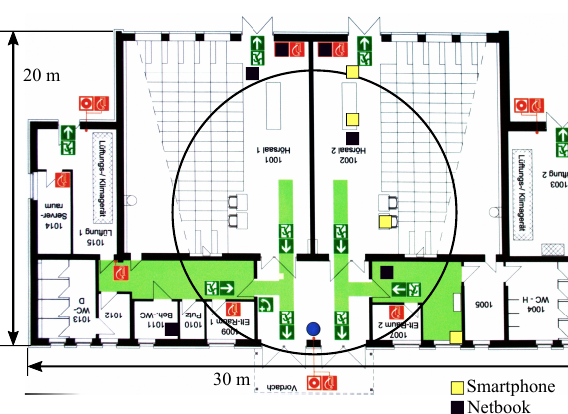
Figure 2. The floor-plan of the Leonardo Da Vinci building. Positions of the smartphones and netbooks are marked